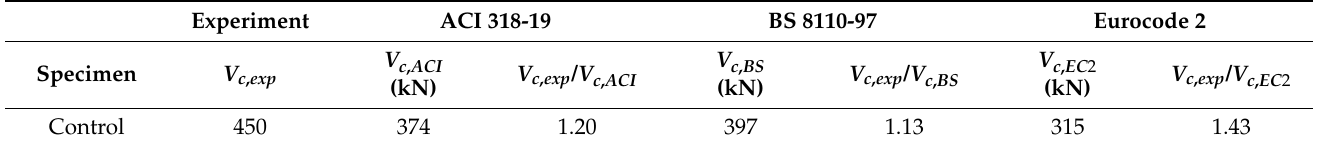
Table 4. Summary of the experimental and theoretical results.